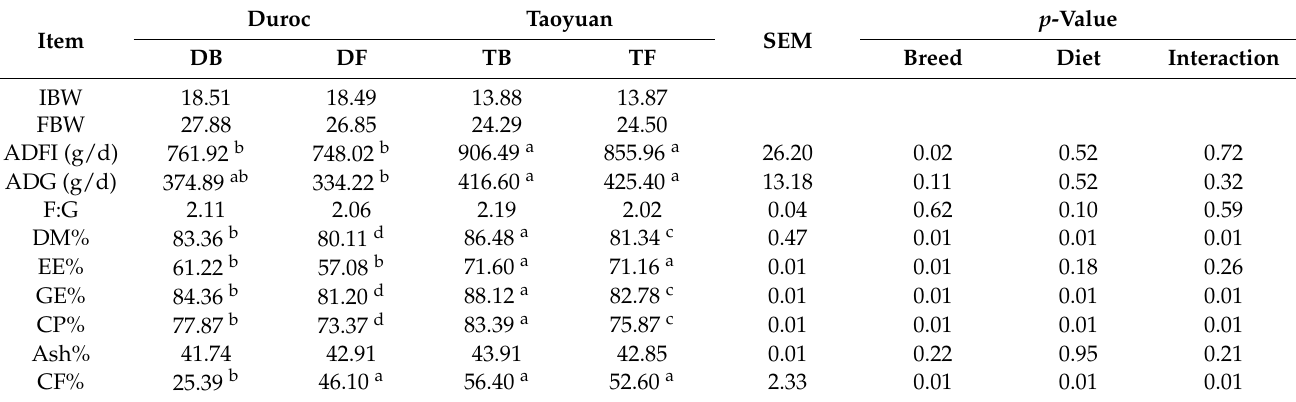
Table 2. Effects of DF on the performance and nutrient digestibility in different pig breeds.